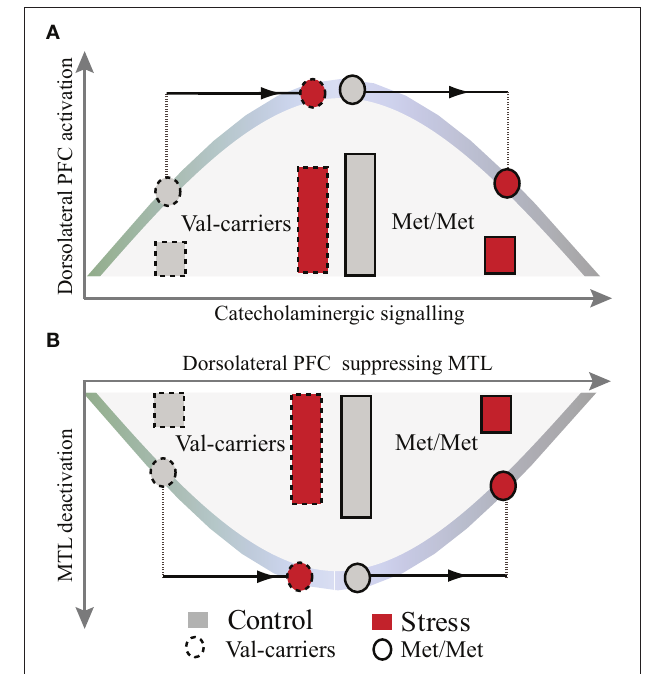
FIGURE 5 | A heuristic model illustrating the effects of COMT genotype and stress on WM-related activation in the dorsolateral PFC and deactivation in the MTL. Stress-by- COMT genotype interaction on the inverted U-shaped curve between levels of catecholamines and dorsolateral PFC function (A) and its suppression of MTL function (B) . COMT Val-carriers, with presumably lower baseline levels of catecholamines, start from the sub-optimal left end of the inverted U-shaped curve, with suboptimal prefrontal WM function and less MTL suppression. Under moderate psychological stress, elevation of catecholamines may shift catecholaminergic signaling toward an optimal state (strong PFC activation and MTL suppression). In contrast, COMT Met-homozygotes, with high baseline catecholamines, might already start closer to the peak of the curve. Stress-induced elevation of catecholamines may therefore more easily shift these individuals toward a supra-optimal state. Note: The bars represent the magnitude of neural activation in the dorsolateral PFC and deactivation in the MTL, respectively. PFC, prefrontal cortex; MTL, medial temporal